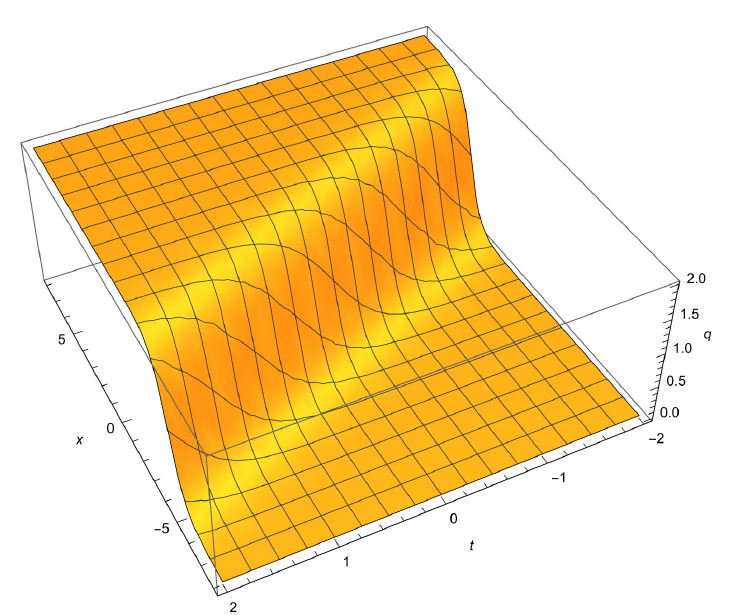
Figure 1. Graph of solution (27) taking the plus